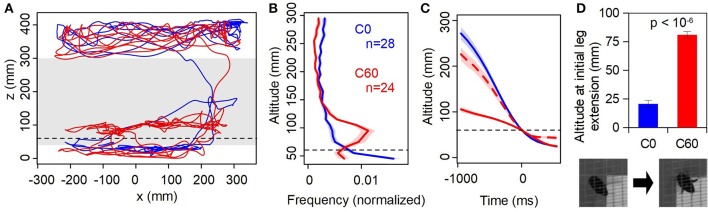
Physical vs. virtual floor. (A) Sample trajectories (1 min duration) from the same individual in the C0 (static, blue) and C60 (virtual reality closed-loop, red). Dashed line indicates the level of the virtual floor, gray shaded band is the range of altitudes shown in (B). (B) Histogram of time spent at altitudes between 40 and 300 mm, averaged across all individuals. Shaded regions are ±1 SE. (C) Event-triggered mean altitude profiles; t = 0 is the first instance of the bee descending below z = 60 mm. Dashed red line is C60 data shifted downwards by 60 mm, i.e., expressed relative to the virtual as opposed to physical floor. (D) Mean altitude at which first leg extension is observed. Inset: stills from overhead camera showing a flying bee with legs retracted (left) and extended (right).